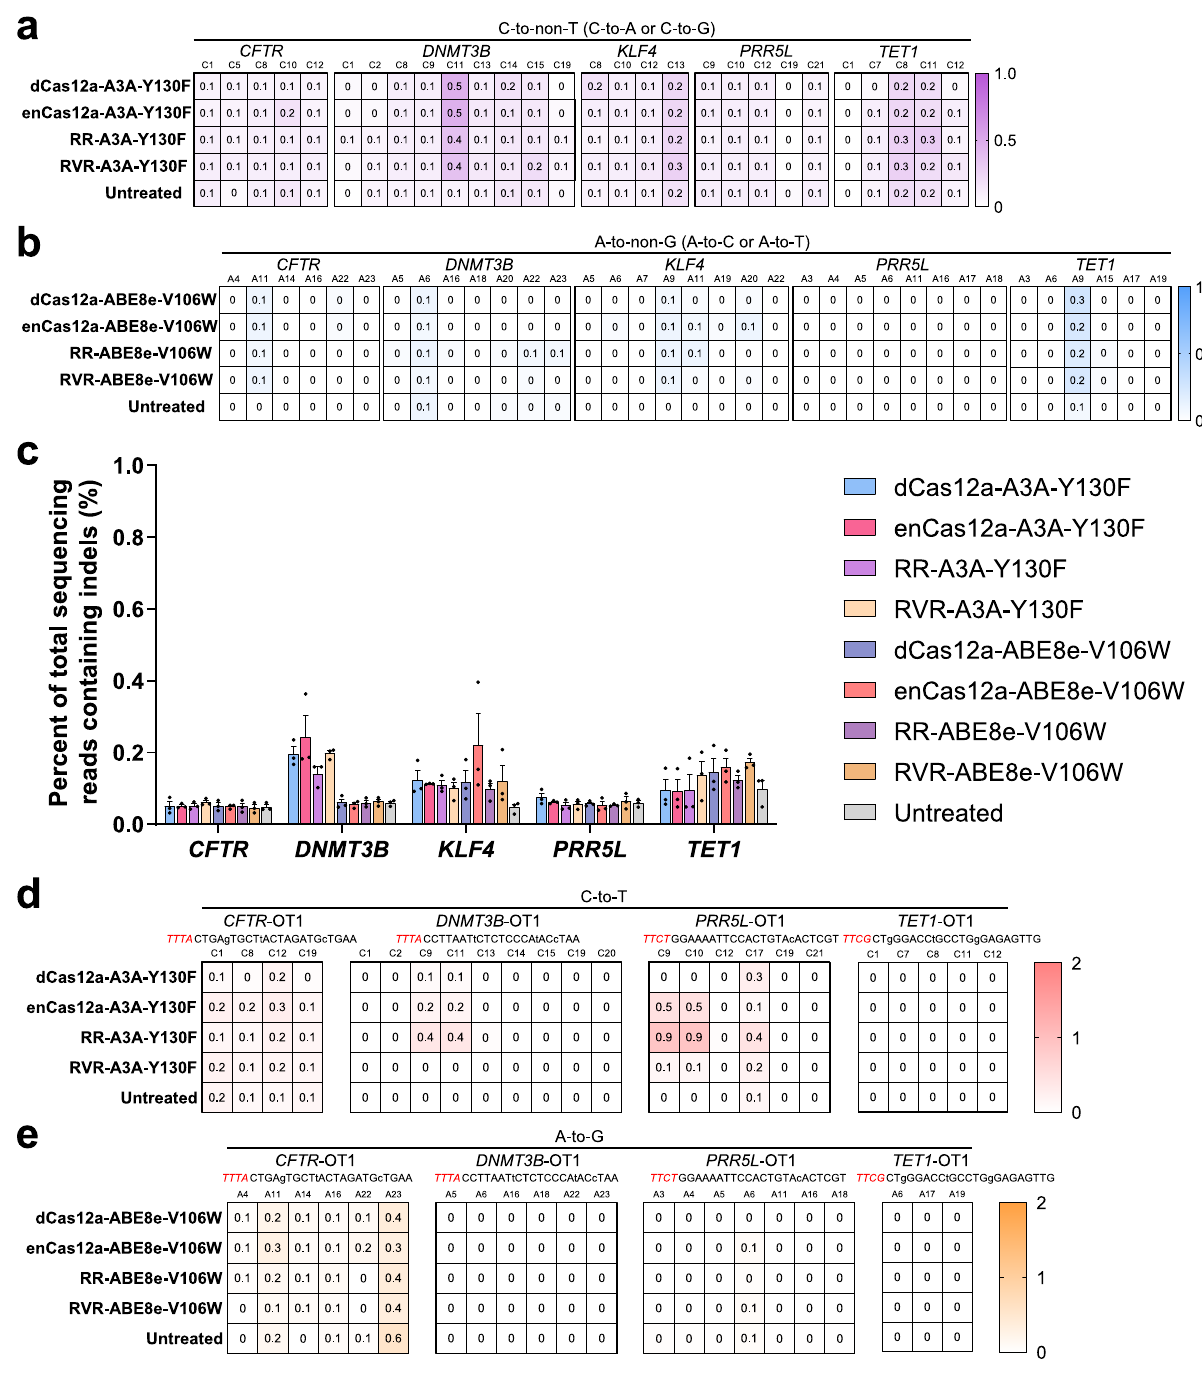
Fig. 5 Speci fi city of Cas12a variant-mediated base editors in HEK293T cells. Heat maps showing the frequencies of C-to-non-T (C-to A or C-to-G) conversion for CBEs ( a ) and A-to-non-G (A-to-C or A-to-T) for ABEs ( b ) at fi ve selected sites with TTTV PAM ( n = 3). c Indels frequencies for indicated CBEs and ABEs at the tested sites ( n = 3). Heat maps showing the Cas12a-dependent off-target activity of indicated CBEs ( d ) and ABEs ( e ) at the predicted off-target sites ( n = 3). The spacer sequences of off-target sites are shown with mismatches marked in lowercase and PAM marked in red and in italics. Values and error bars represent the mean and SEM, respectively. All heatmaps show the mean of three independent biological